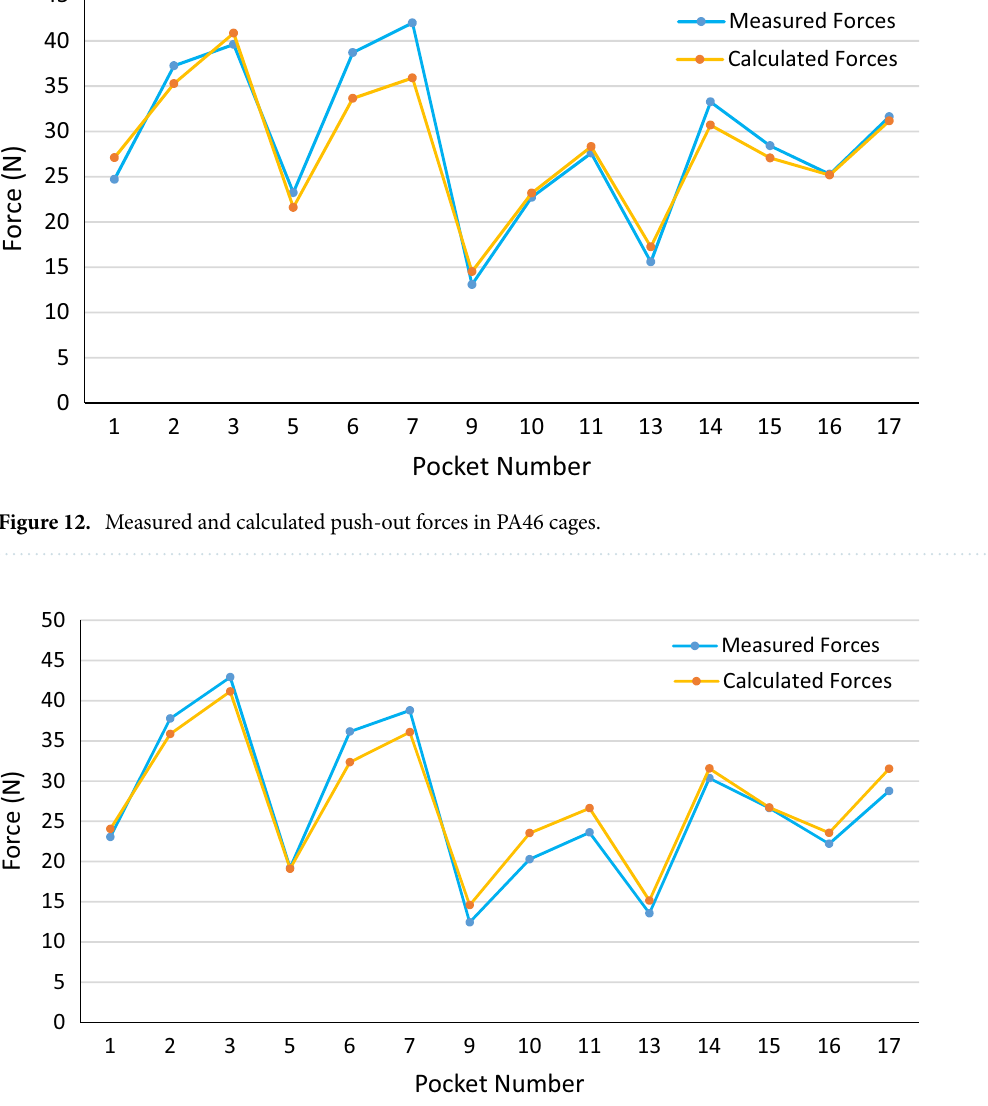
Figure 13. Measured and calculated push-out forces in PA66